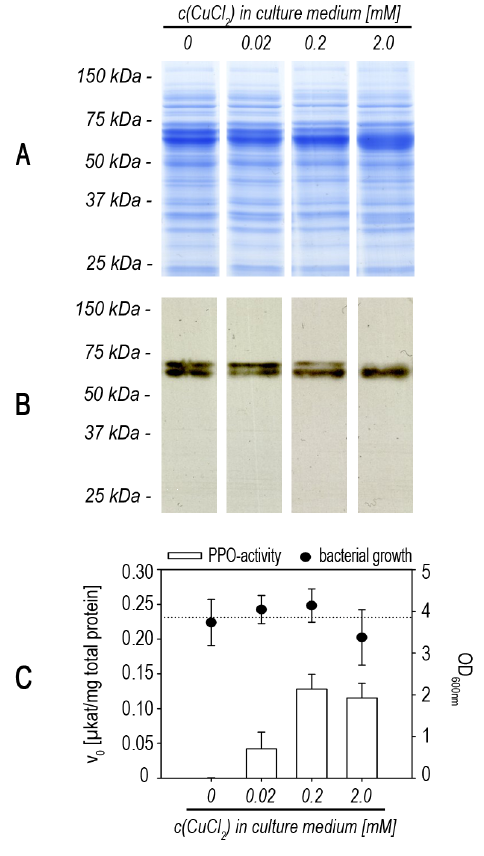
Figure 6. Dependency of PPO-expression on the amount of copper. Production cultures were grown with different amounts of CuCl 2 supplemented in the AIM. A SDS-PAGE of crude protein extracts. Samples were taken after 48 h and analyzed by SDS-PAGE (equal total protein amount per well). To visualize protein composition a Coomassie-staining was performed. B Western blot analysis. Proteins were blotted on a nitrocellulose membrane. StrepTactin-HRP- conjugate was used to specifically detect the StrepII-tag of the recombinant PPO. C Bacterial growth and PPO-activity. Samples were checked for their OD at 600 nm. The average value from all samples is given as a dotted line. Additionally, crude protein extracts were analyzed for PPO-activity per mg of total